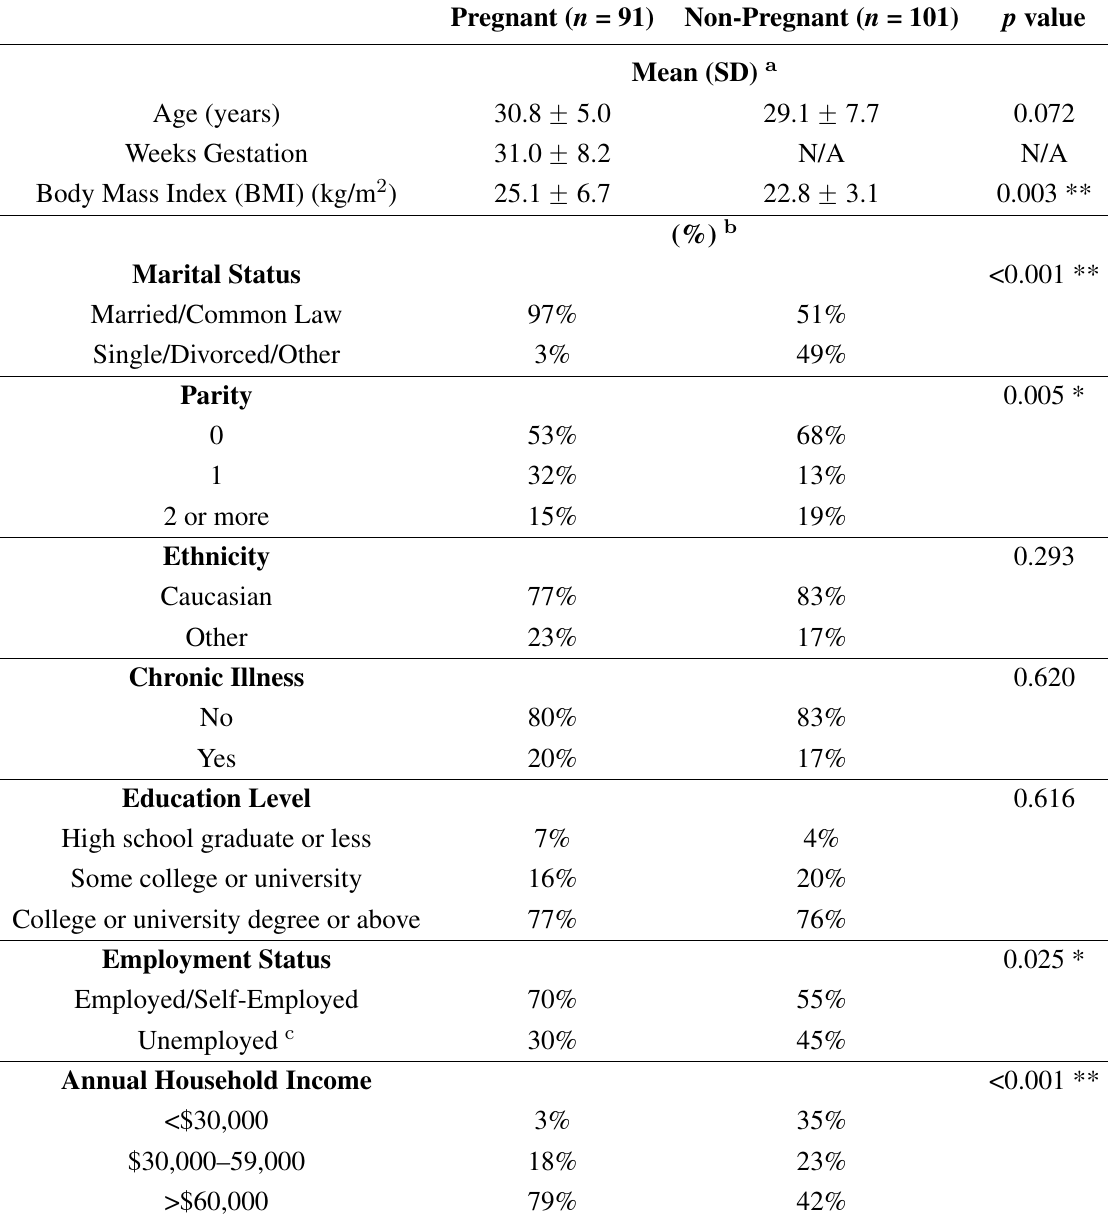
Table 1. Participant Demographic Characteristics.